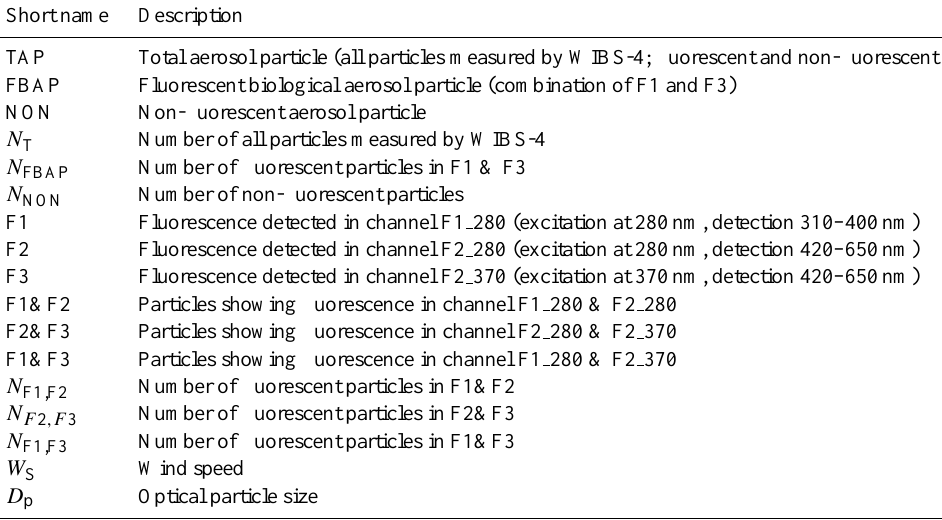
Table 1. Definition of abbreviations used in the